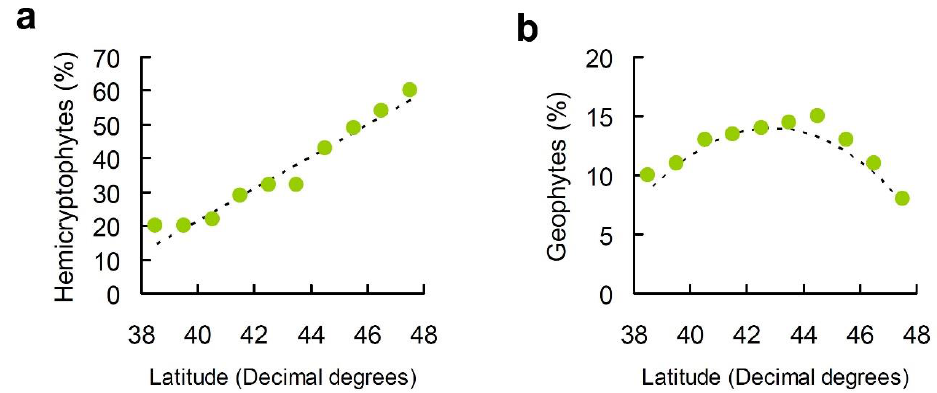
Figure 6. Relationship between percentage of ( a ) hemicryptophytes and ( b ) geophytes and latitude on a Central Apennine mountain (Mount Genzana) fitted using conditional autoregressive models.